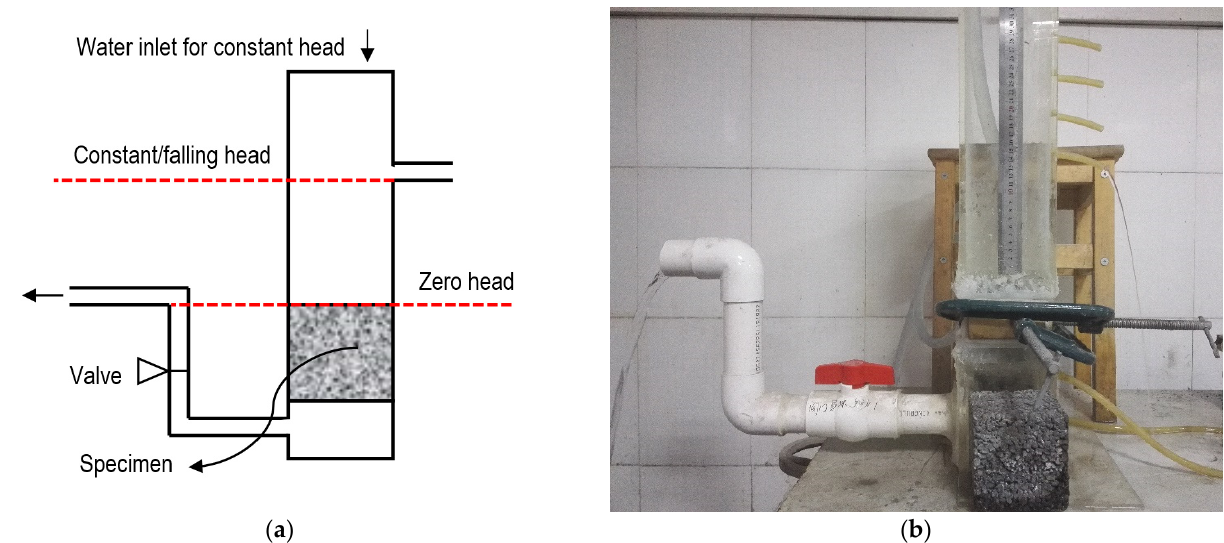
Figure 9. ( a ) Diagram for the setup of water permeability test for pervious concrete under constant and falling water head, and ( b ) the real setup.